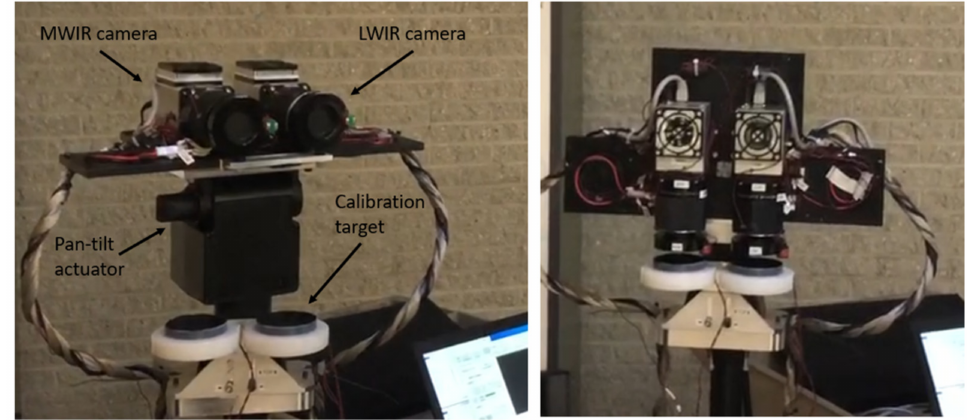
Figure 1. The Bomberos bi-spectral imaging system, shown in observation (left) and calibration (right)